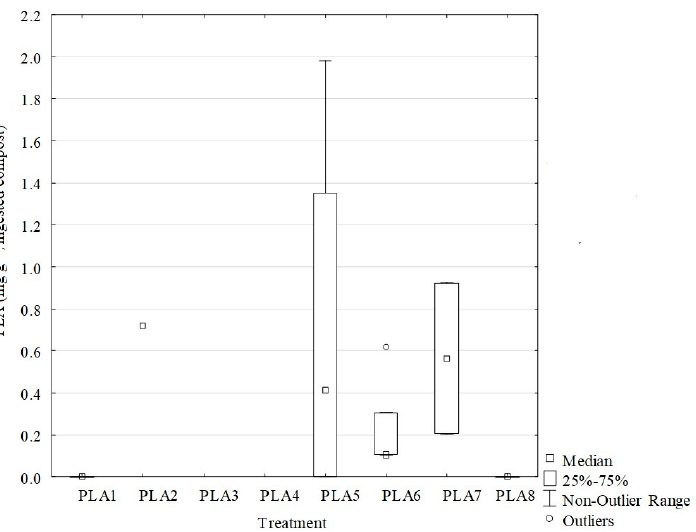
Figure 1. Concentration of polylactic acid (PLA) in earthworms burrows (ingested compost, mg·g − 1